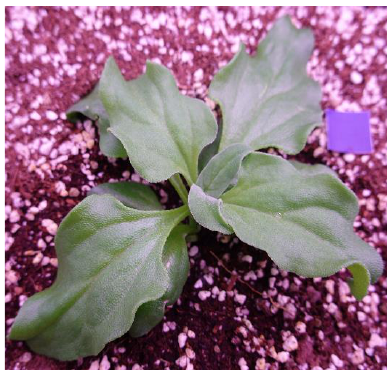
Figure 3. Image acquisition system of ice plant canopy.